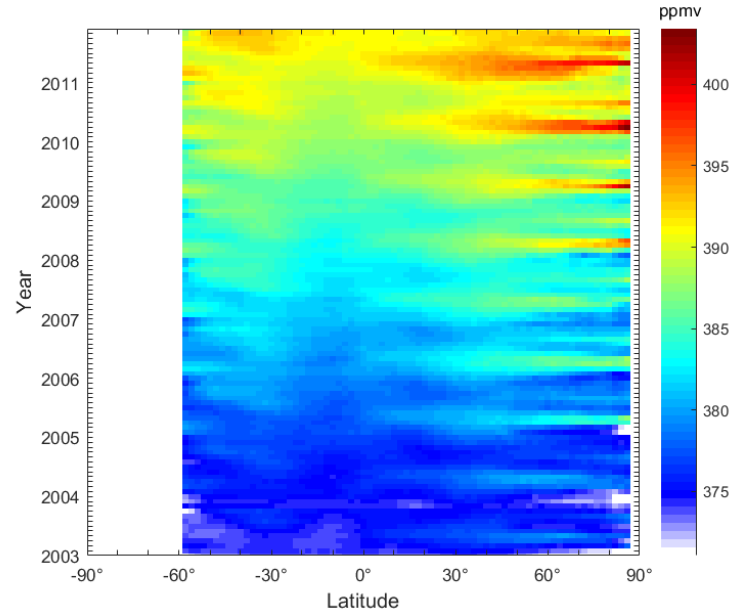
Figure 13. Time–latitude Hovmöller diagram of monthly average CO 2 concentration in mid-troposphere based on AIRS from March 2003 to February 2012. The regions without effective data are not included.